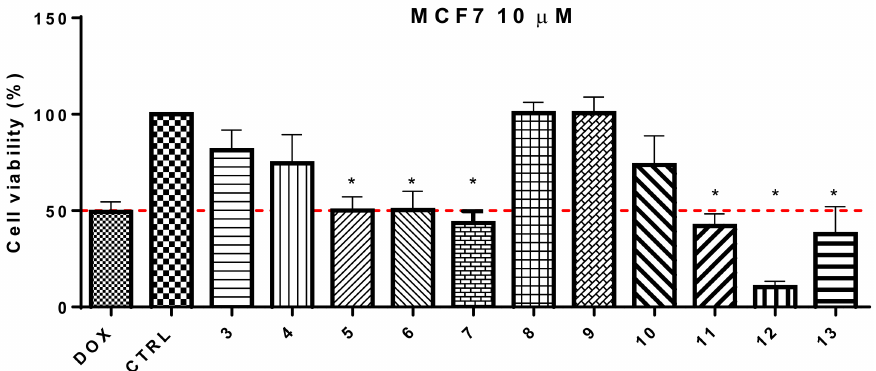
Figure 2. Cell viability of the synthesized chalcones with 10 µ M treatments in MCF-7 cells. *—cell viability ≤ 50%.